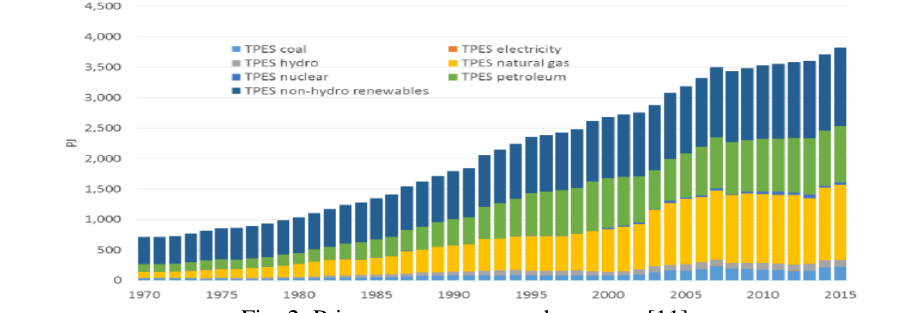
Fig. 2: Primary energy means by source [11]